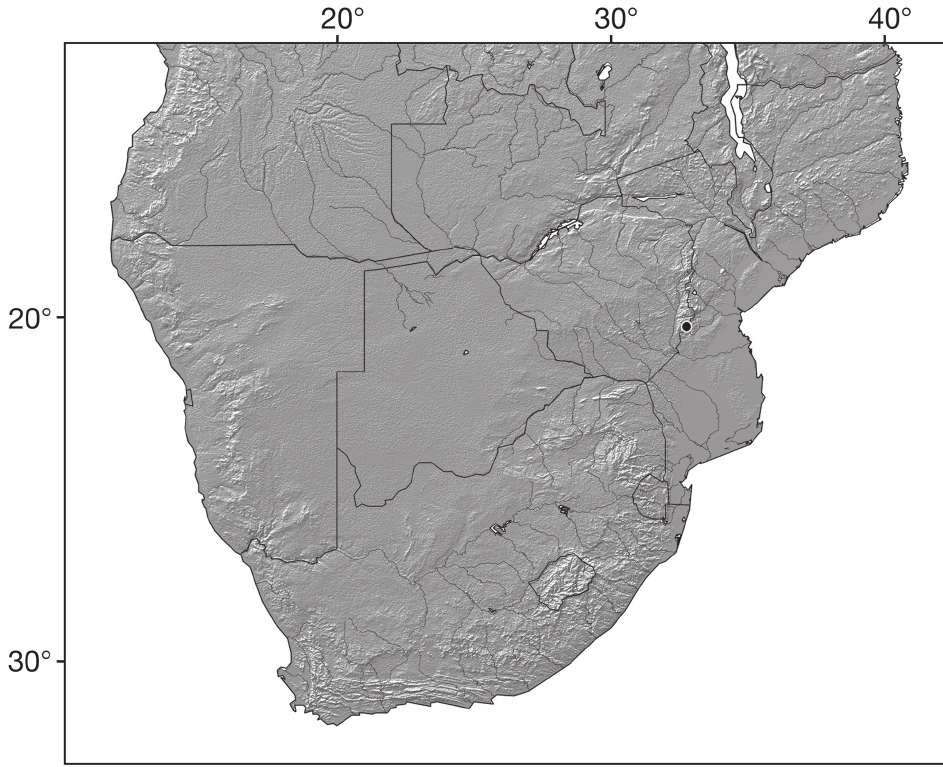
Figure 9. Map of southern Africa showing the type locality of V. chirindensis sp. n. in Zimbabwe (20°24’S